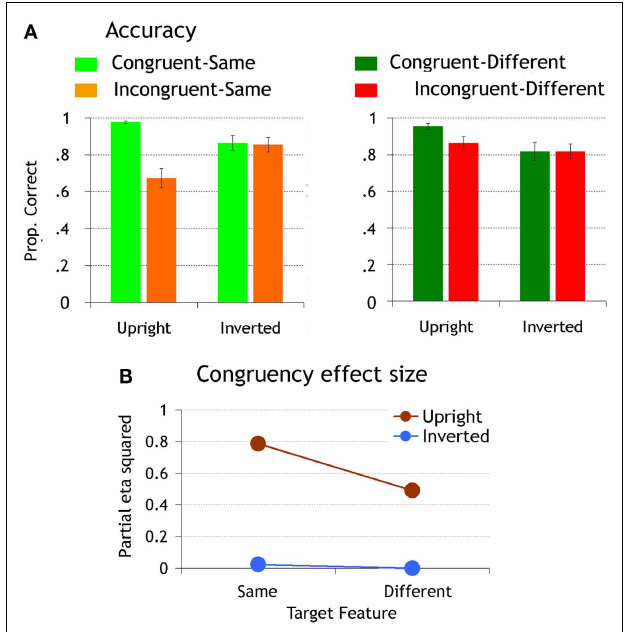
FIGURE 2 | (A) Matching accuracy. Error bars represent standard error of the means. (B) The size of the congruency effect is plotted for upright and inverted faces as a function of target feature